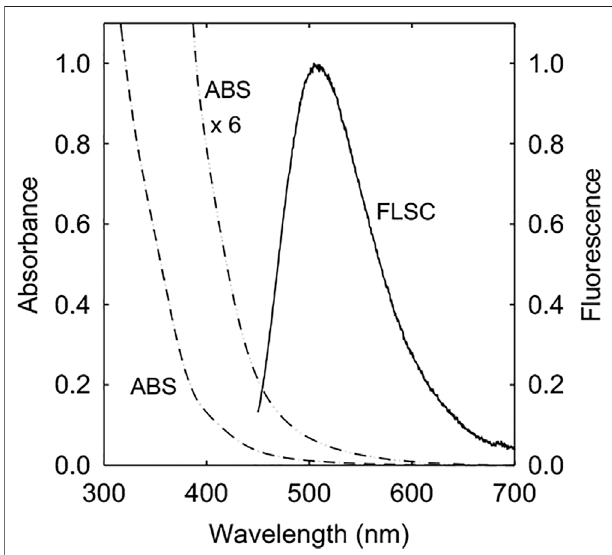
FIGURE 2 | Absorption (ABS) and fl uorescence (FLSC, 440 nm excitation) spectra of EDA-CDots in aqueous